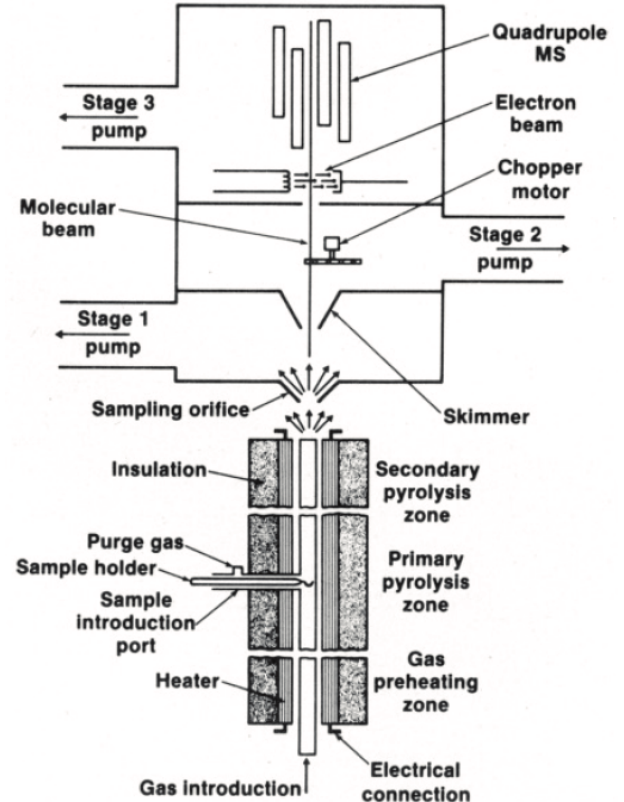
Figure 3. Detailed description of the burner-Molecular Beam Mass Spectrometer